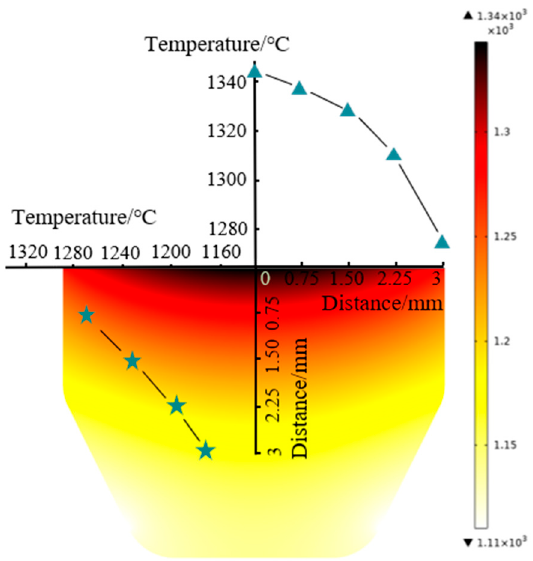
Figure 8. The temperature field distribution of the billet at the end of the holding time.